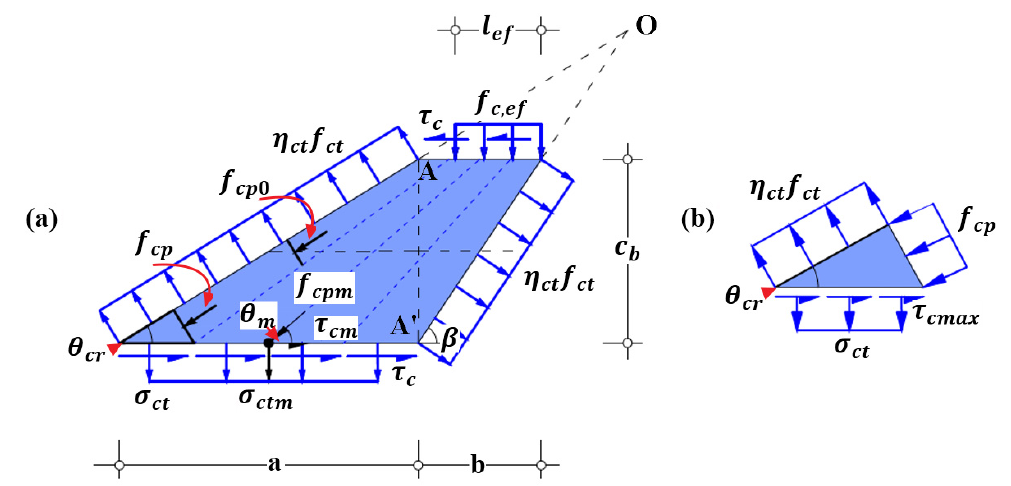
Figure 8. Stress field approach for predicting end concrete cover separation: ( a ) standardized stress field for cracked concrete block; and ( b ) the end of micro concrete strut.